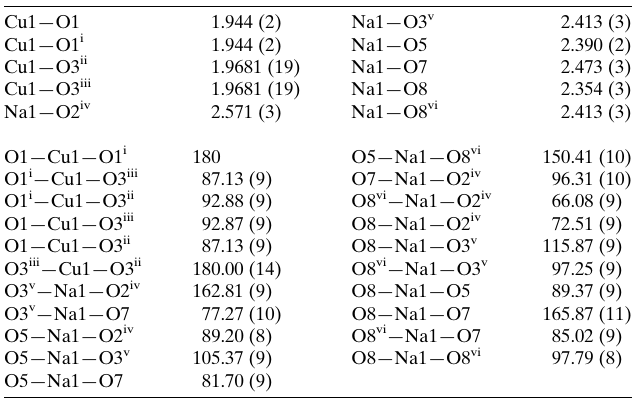
Table 1 Selected geometric parameters (A˚ , (cid:5) ).